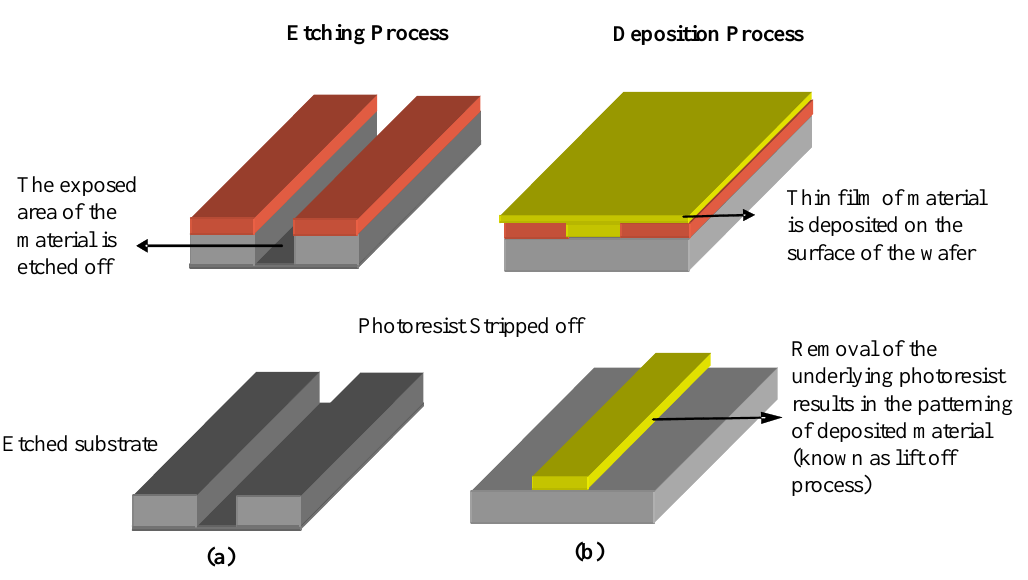
Figure 2. Illustration of Etching and Deposition process in MEMS